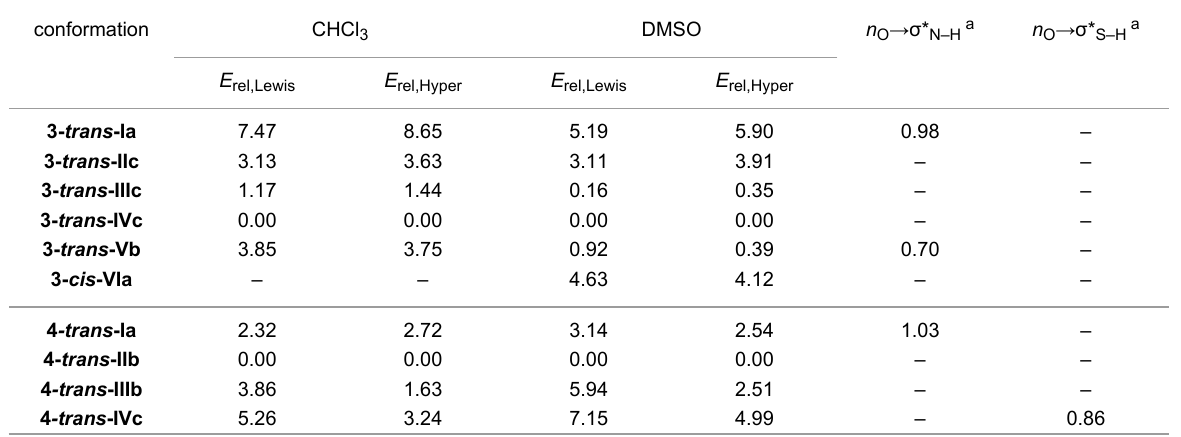
Table 7: NBO parameters for conformers of compounds 3 and 4 , calculated at the ω B97X-D/aug-cc-pVTZ level of theory. Relative energy of the steric ( E rel,Lewis ) and hyperconjugative ( E rel,Hyper ) interactions are given in kcal mol − 1 . The sum of E rel,Lewis and E rel,Hyper is the total energy of the system.